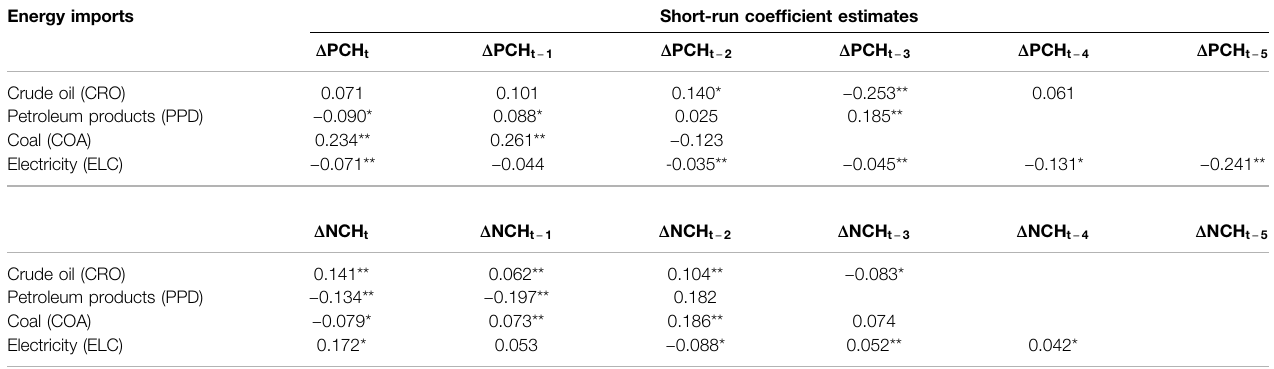
TABLE 2 | NARDL short-run estimates of positive and negative forex volatilities.